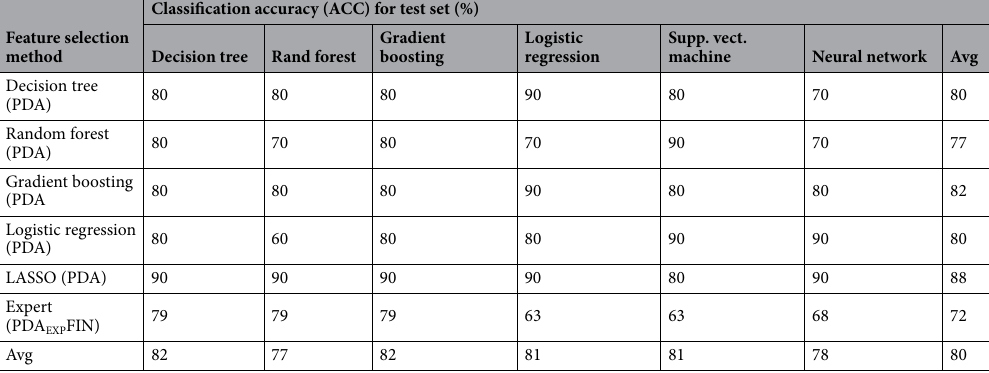
Table 10. Performance of applied combinations of dimensionality reduction and classification techniques on test set for PDA and PDA EXP FIN data.